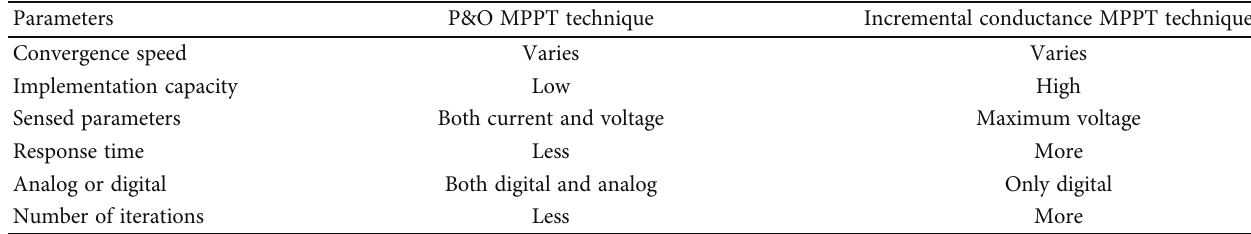
Table 1: Comparison of P&O, incremental conductance MPPT